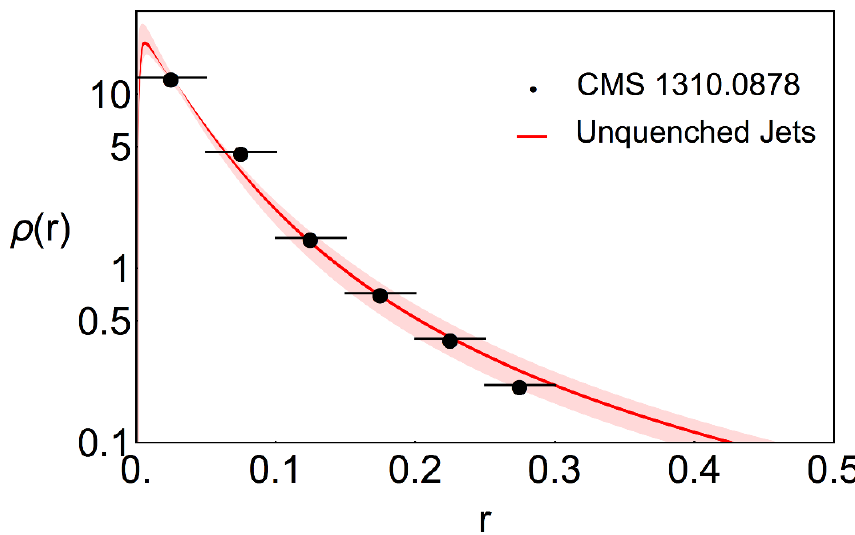
Figure 8 . Mean jet shape in vacuum as a function of r , the angle in ( (cid:17); (cid:30) )-space from the center of the jet, computed from the ensemble of null strings described in the text compared to CMS measurements of the mean jet shape for jets with energy above 100 GeV reconstructed with anti- k t p reconstruction parameter R = 0 : 3 in proton{proton collisions with s NN = 2 : 76 TeV at the LHC from ref. [33], shown as black symbols. The pink band shows the results obtained from our ensemble of strings for a range in the free parameter given by a = 1 : 8 (cid:0) 2 : 5, with a = 2 shown in dark red. Although the e(cid:11)ects of doing so are negligible here, the experimental data and the results of our calculations have been smeared in order to take into account the CMS jet energy resolution, as described in ref. [33] and later in the